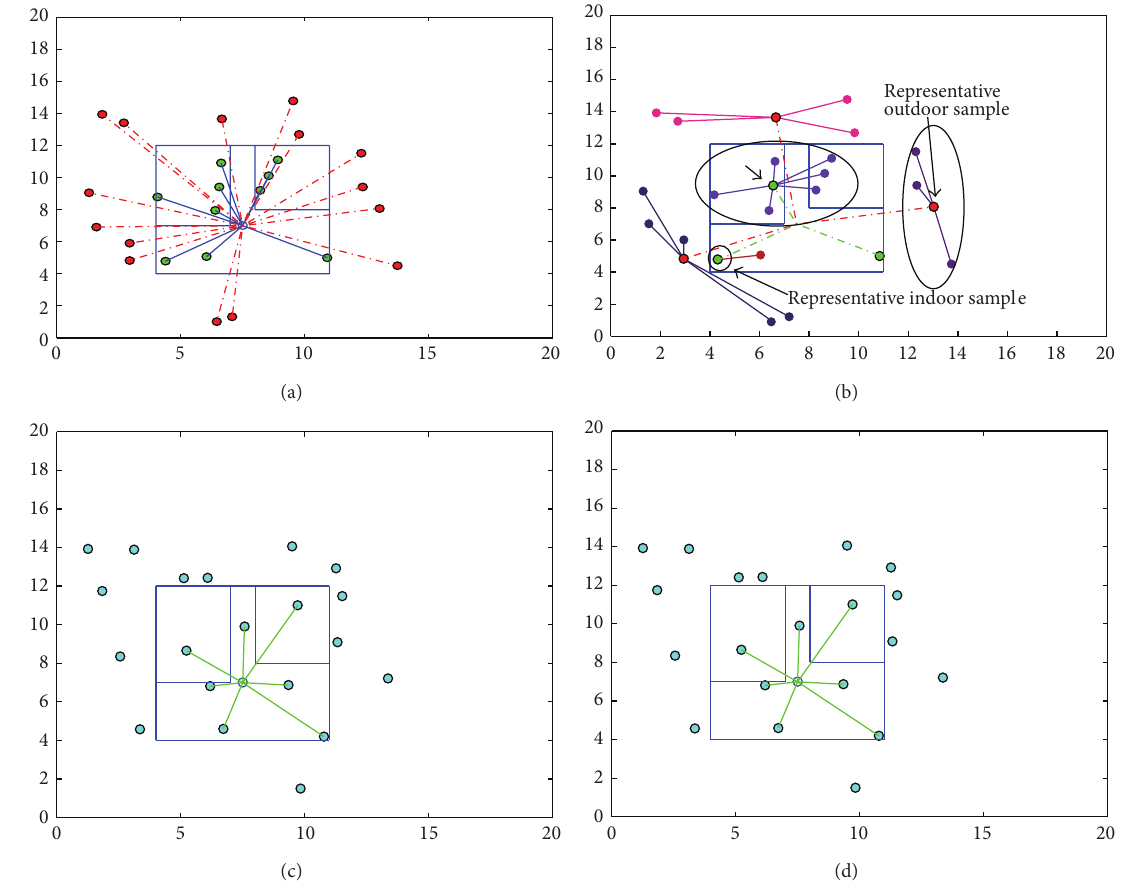
Figure 9: (a) Training with ANN. (b) Training with ANN+AP. (c) Performance of the network with ANN training. (d) Performance of the network with ANN+AP